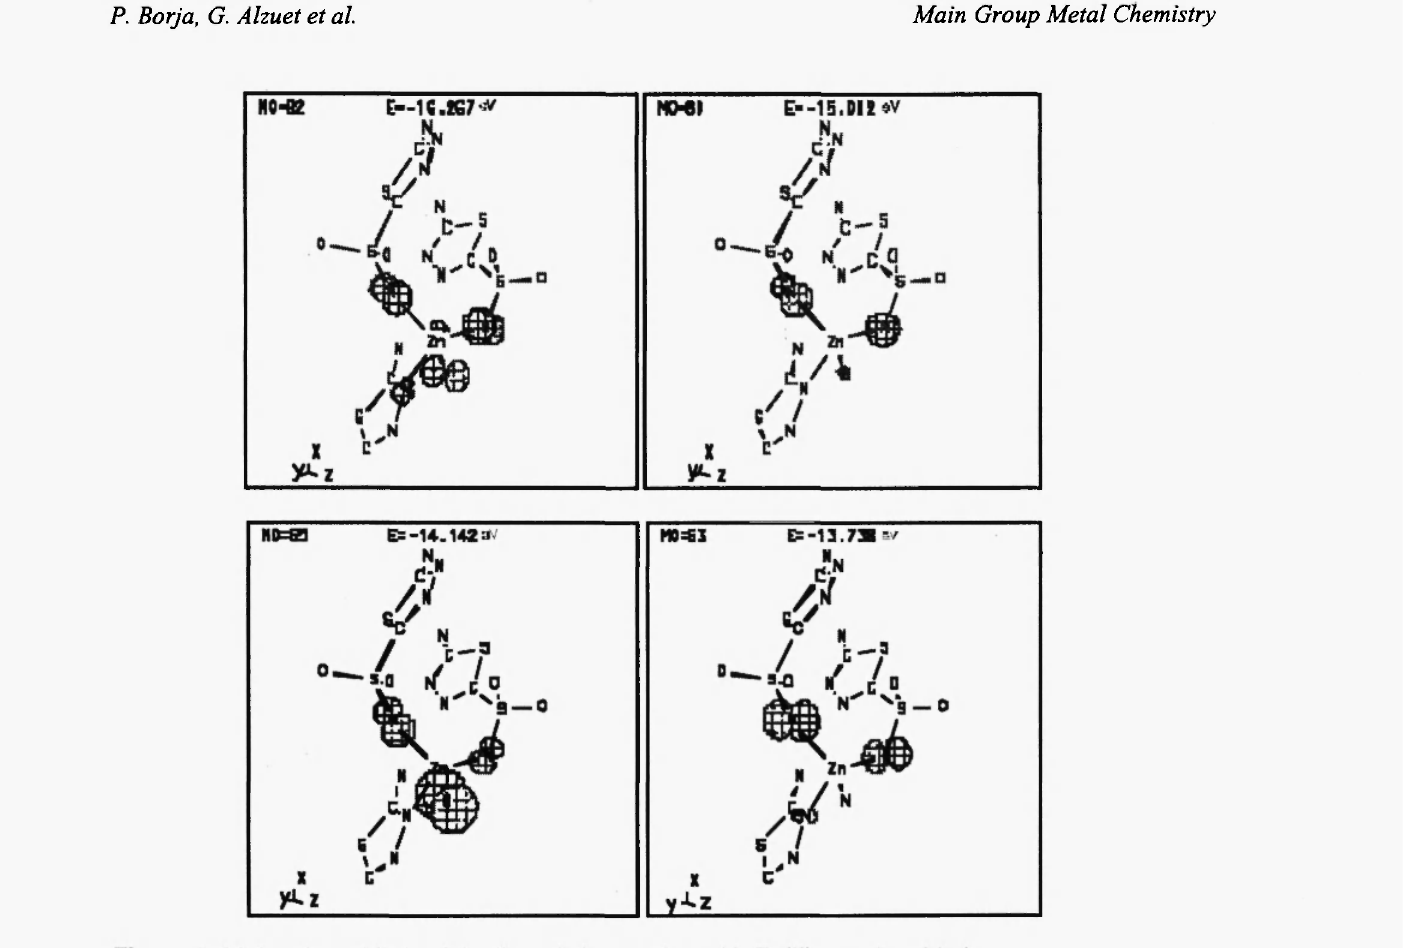
Figure 9. Molecular orbitals of the ligands interacting with Zn(ll) atomic